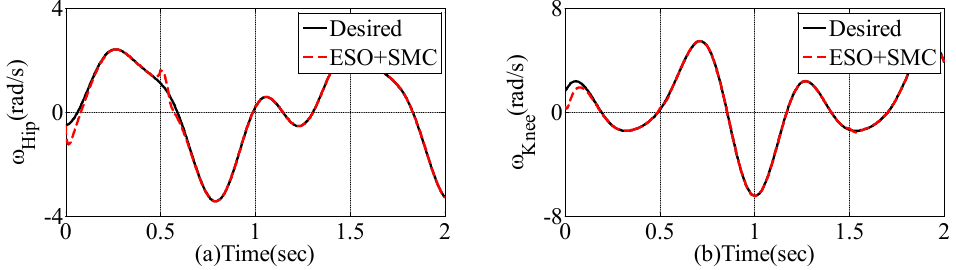
Figure 11. Joint angle velocity tracking of the hybrid phase: ( a ) Hip joint; ( b ) Knee